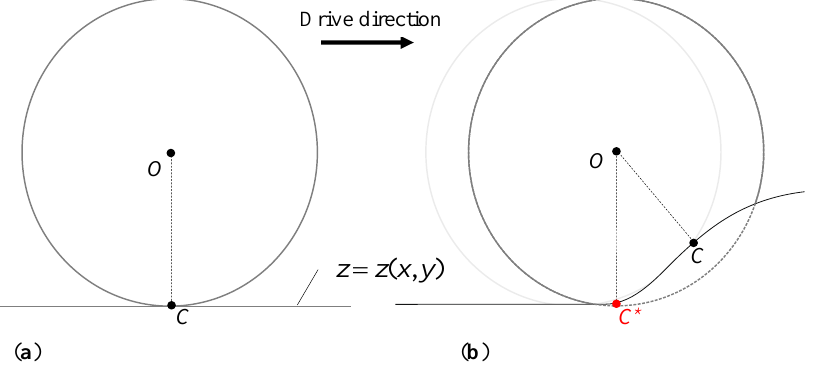
Figure 2. An example of obtaining a contact point location on the road surface, ( a ) the flat road surface, ( b ) the uneven road surface.